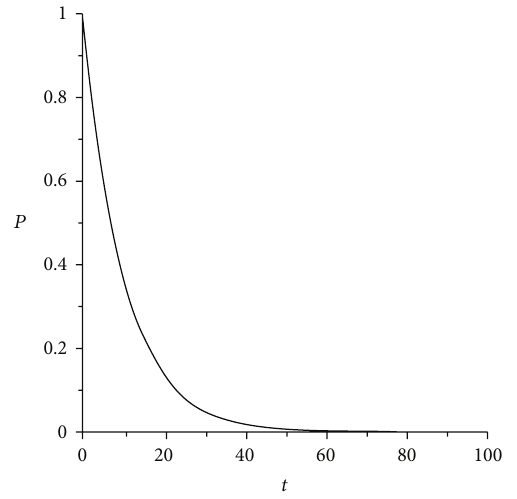
Figure 1: Popularity fades